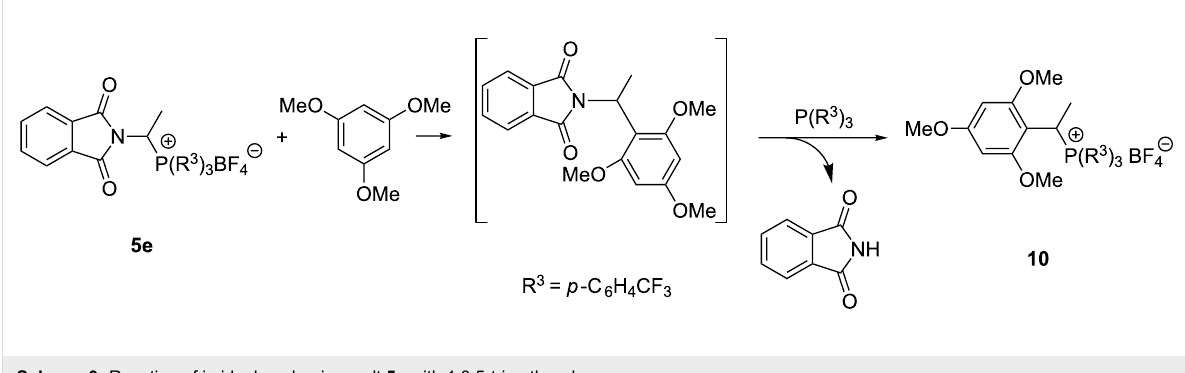
Scheme 3: Reaction of imidophosphonium salt 5e with